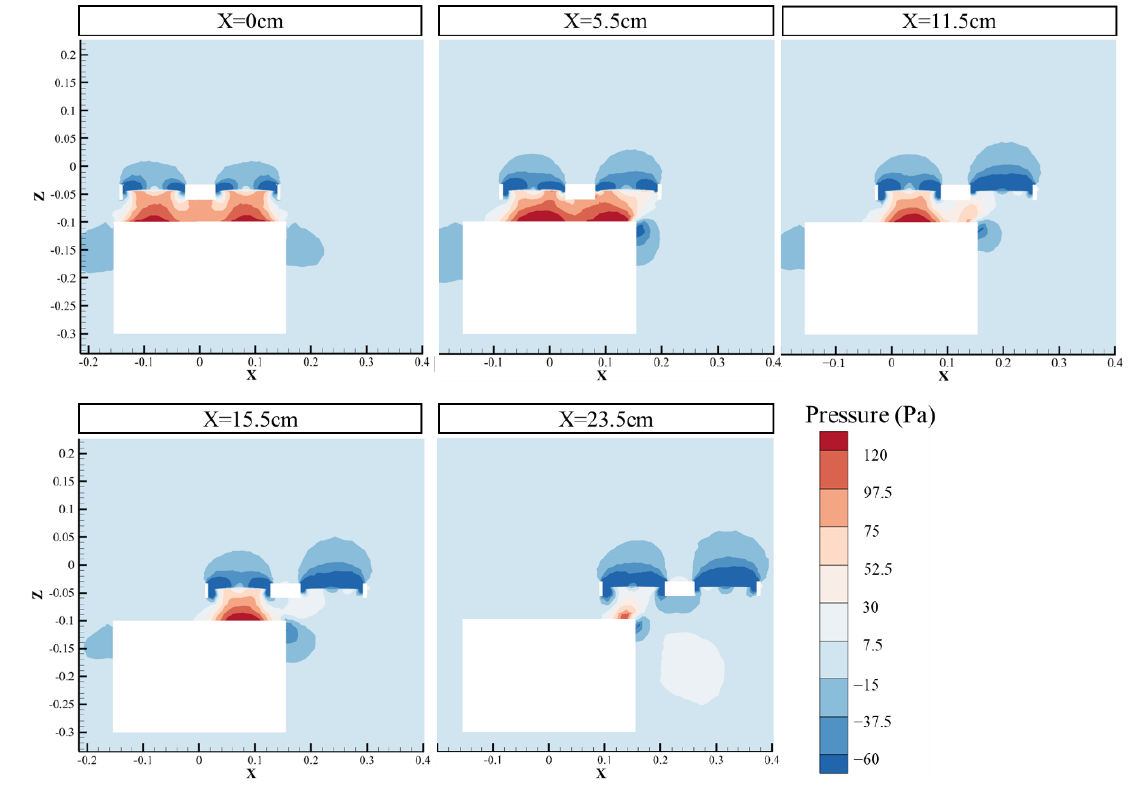
Figure 23. The flow filed of body-outside transition area.